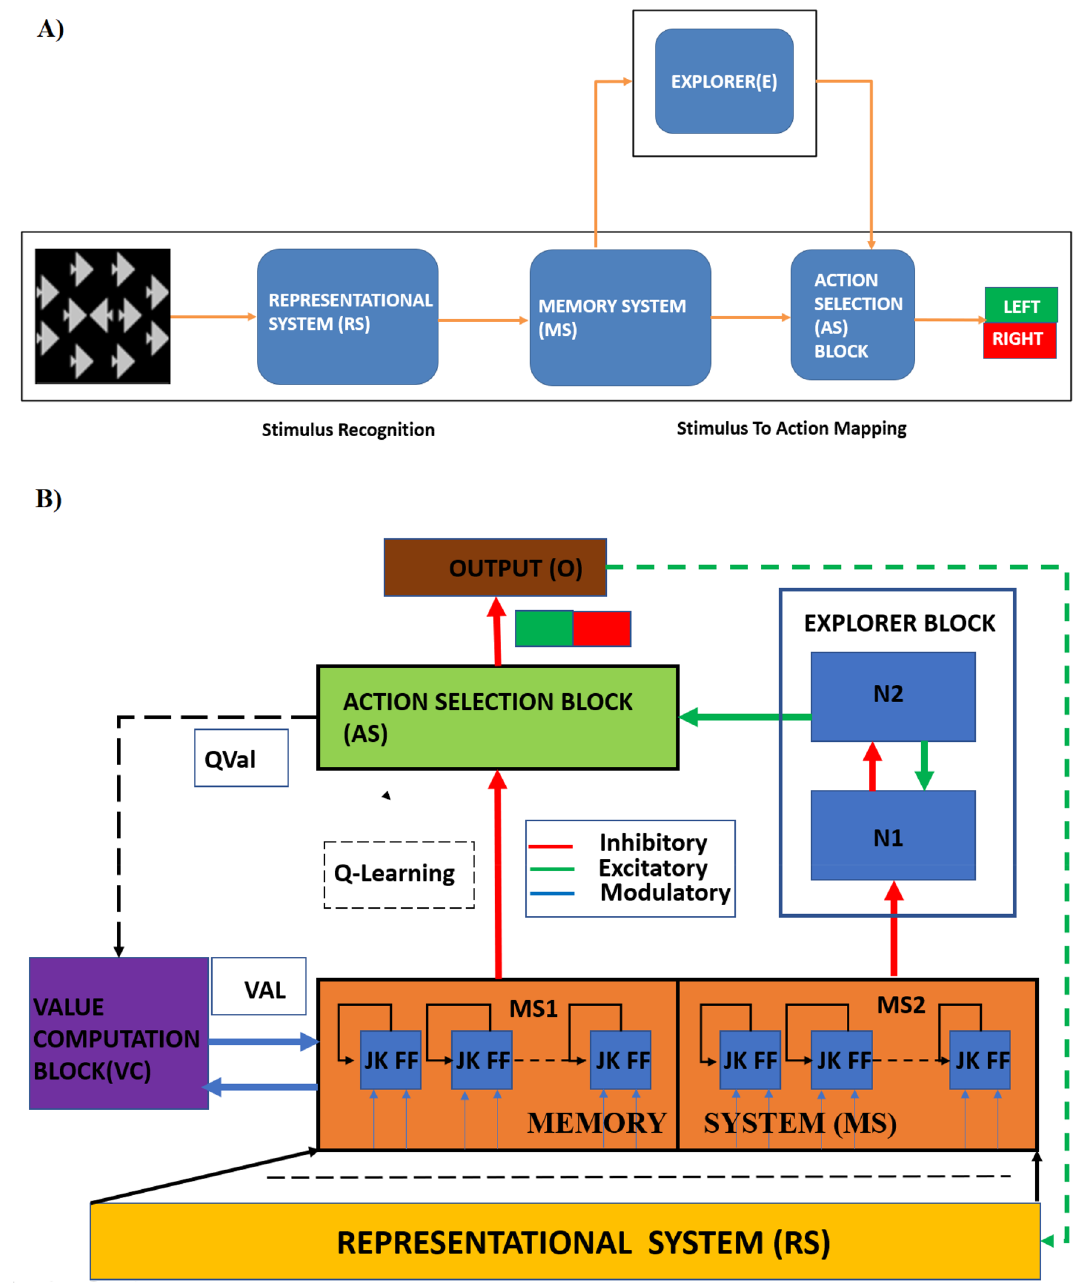
Figure 1. ( A ) Overview of (Generalized Reinforcement Learning-based Deep Neural Network) GRLDNN model architecture. RS, Representational System is used for stimulus recognition; Memory System (MS) and Action Selection (AS) block along with the Explorer (E) is used for stimulus to action mapping. The encoder output from RS is presented to the MS where the stimulus is processed, and the action selection takes place at AS. ( B ) Block diagram of the Agent Model architecture. RS, Representation System Block; Explorer Block consisting of N1/N2 Oscillator pair; AS, Action Selection Block; O, Output block; VAL, Value Computation Block where the Value function is computed; QVal, Q-value function; MS, Memory System